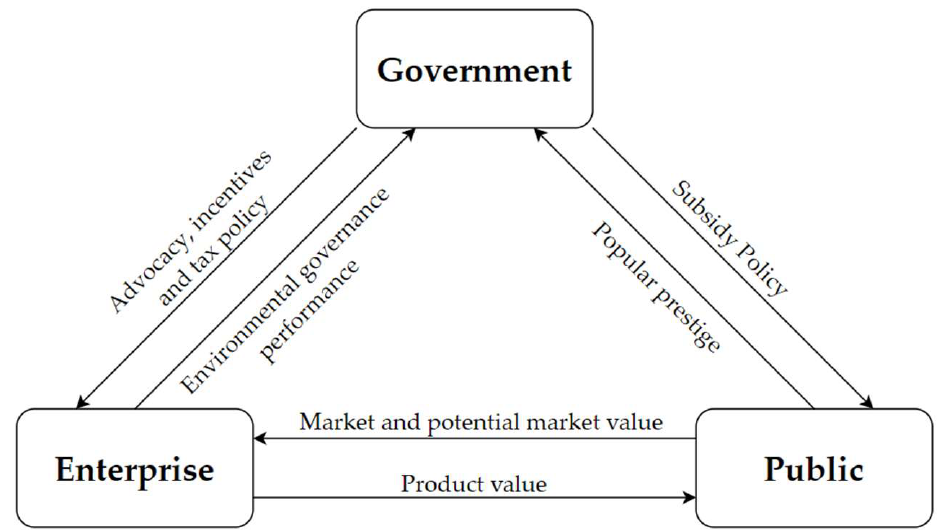
Figure 1. Multi-agent driving mechanism under the background of CPAN policy and carbon labelling system.